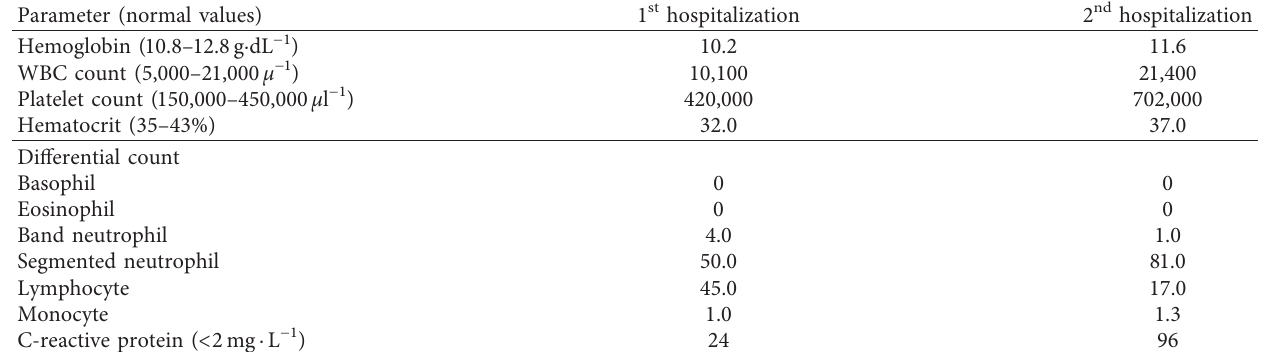
Table 1: Comparison of laboratory values between the first and second hospitalization